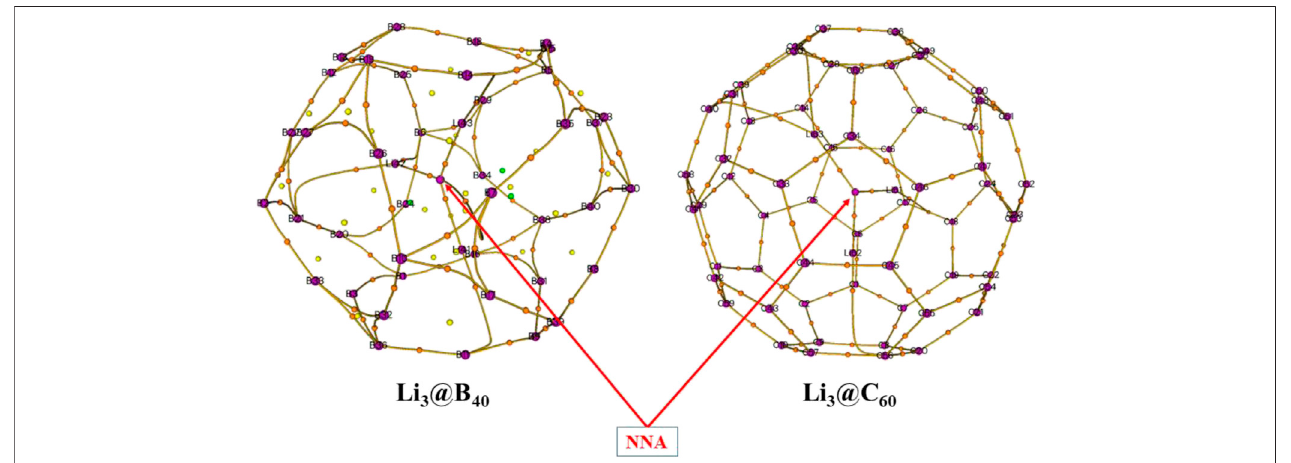
FIGURE 7 | The plots of molecular graphs of Li 3 @B 40 and Li 3 @C 60 systems generated at BP86-D3/def2-TZVPPD//BP86-D3/def2-TZVPP level.